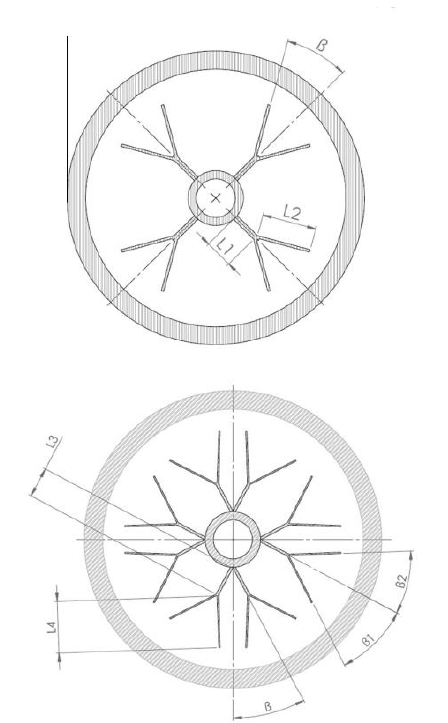
Figure 7 Fin configuration: single bifurcation (top), double bifurcation (bottom) [20]